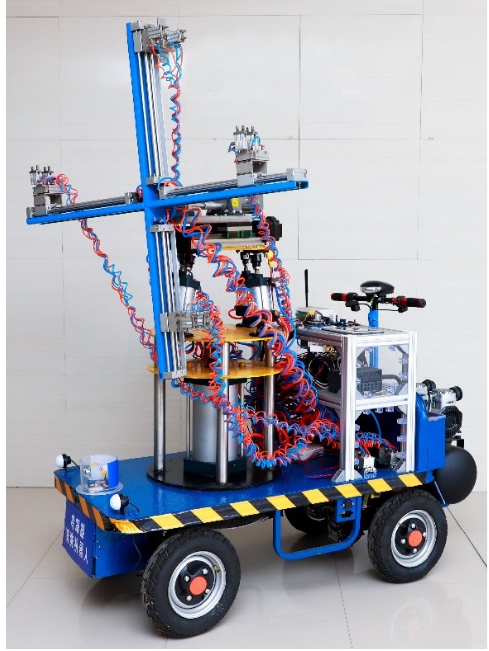
Figure 9. Prototype of cleaning robot for hybrid condenser.